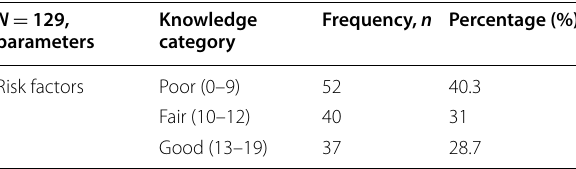
Table 3 Distribution rank of awareness of stroke risk factors among the participants